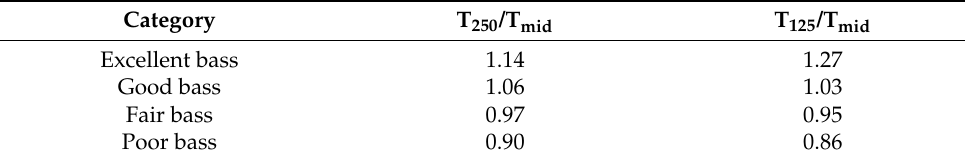
Figure 13. Sound source and measurement points.